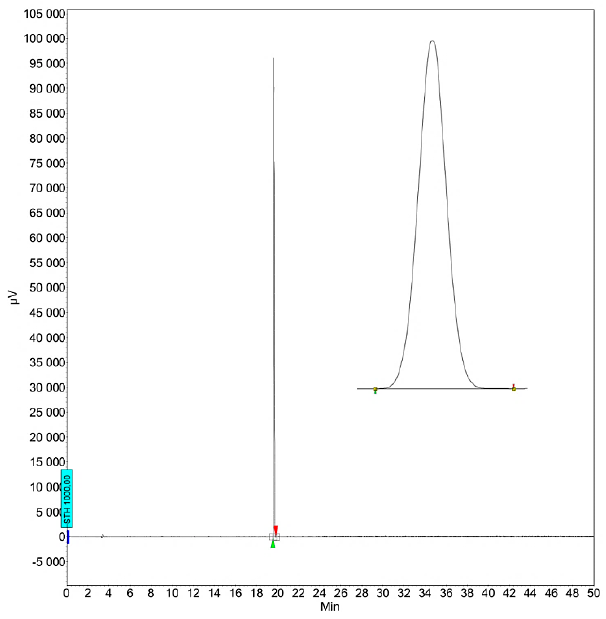
Figure 4. Sample chromatogram generated for a mixture of THT in M/H15 with a THT concentration of 6.70 ppm ( x THT = 24.60 ± 0.50 mg/m 3 , T = 20 ° C and P = 101.325 kPa).